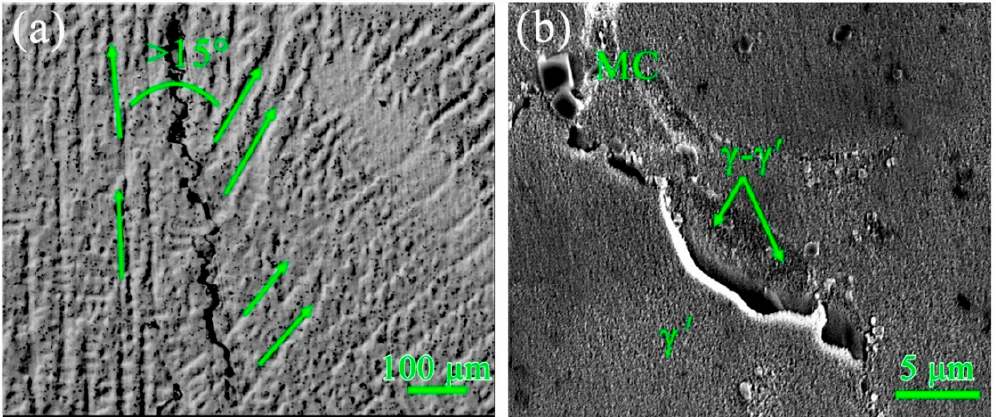
Figure 13. Cracks in the AF sample. ( a ) Optical microscope (OM) image of grain boundary cracks with green arrows indicating different growth directions of dendrites in two grains; ( b ) SEM image of cracks decorated by fine γ′ particles, γ – γ′ eutectics and some MC carbides.